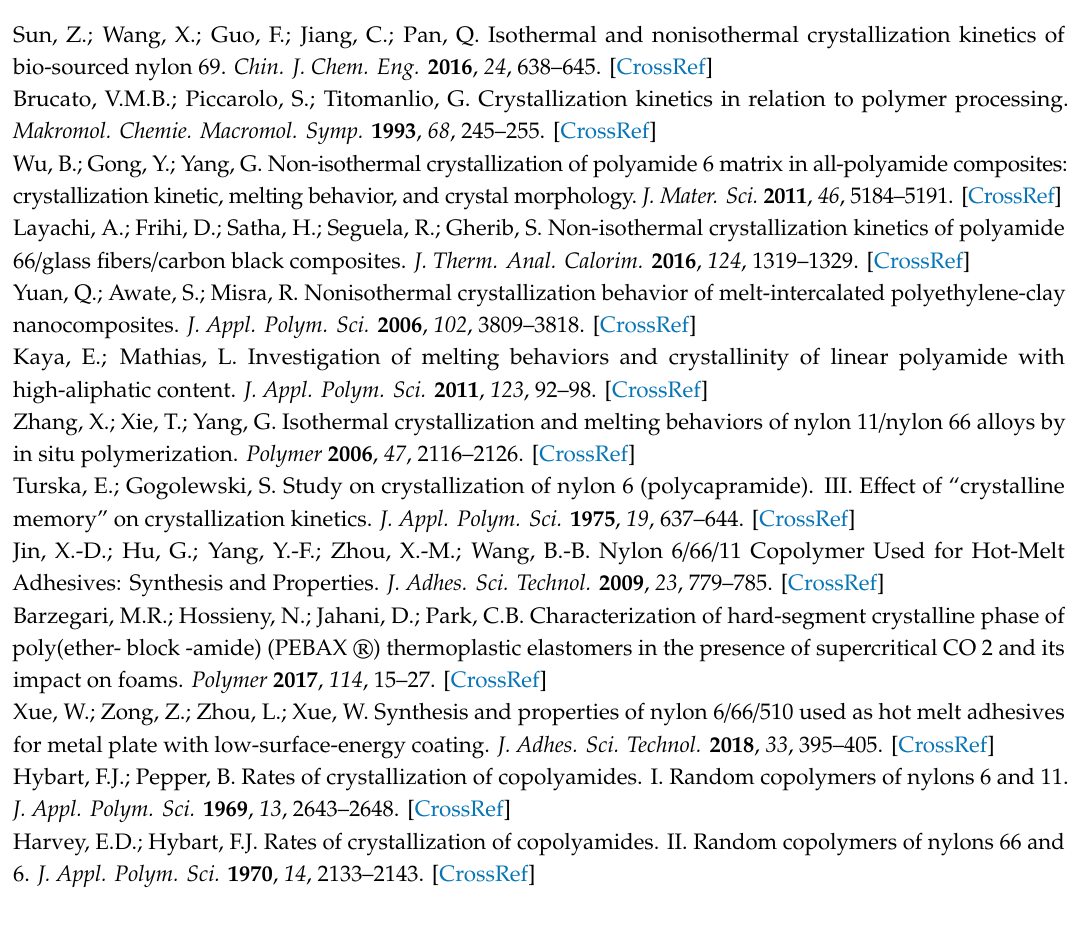
Table S1: Composition and relative viscosity of the PA6 and PA6 / (BAEA / AA) copolyamides, Table S2: Thermal properties of PA6 and PA6(BAEA / AA) copolyamides at non-isothermal conditions, Table S3: Thermal properties and the calculated crystallization degrees of PA6 and PA6(BAEA / AA) copolyamides, Figure S1: 1H NMR (left) and FT-IR (right) spectra of PA6-10 (CF3COOD, 300 MHz), Figure S2: The tan δ curves of PA6 and PA6(BAEA / AA) copolyamides, Figure S3: The plots of ln[ − ln (1 − X( t ))] versus ln( t ) via the Avrami equation during the di ff erent isothermal processes for the (a) pure PA6, (b) PA6-5, (c) PA6-10, and (d) PA6-15, Figure S4: The crystallization activation energy ( ∆ Ea) PA6 for copolyamides at di ff erent contents of BAEA / AA via the Arrhenius method, Figure S5: Lauritzen–Ho ff man plot for PA6 copolyamides at di ff erent contents of BAEA /